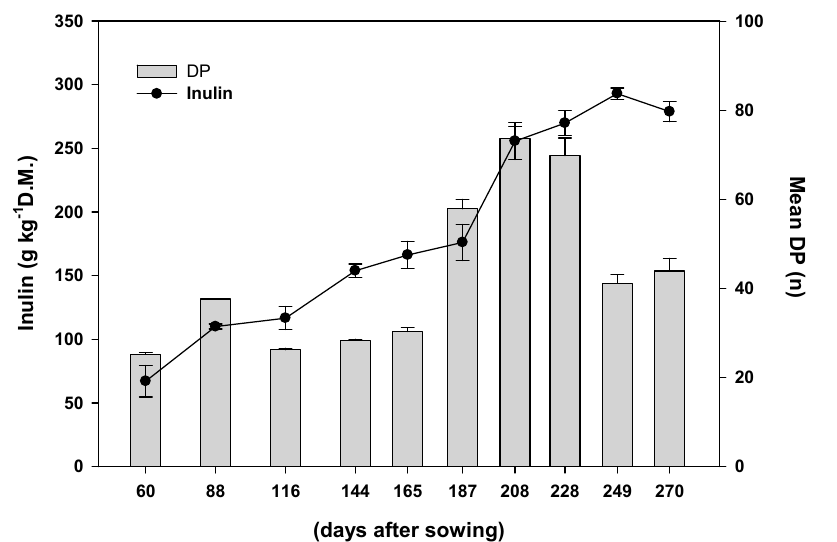
Figure 4. Inulin accumulation in roots and its relative degree of polymerization (mean DP) variations during the growth cycle of wild cardoon. Vertical bars indicate standard deviation values.